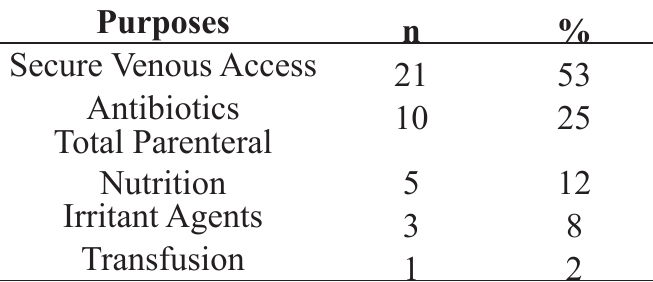
TABLE 3 - Main purposes for PICCs.